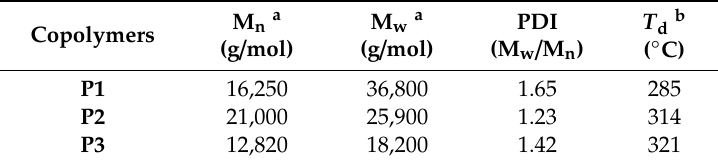
Table 1. Molecular weights and thermal properties of copolymers. Scheme 1. Synthetic scheme for P1–P3 copolymers.